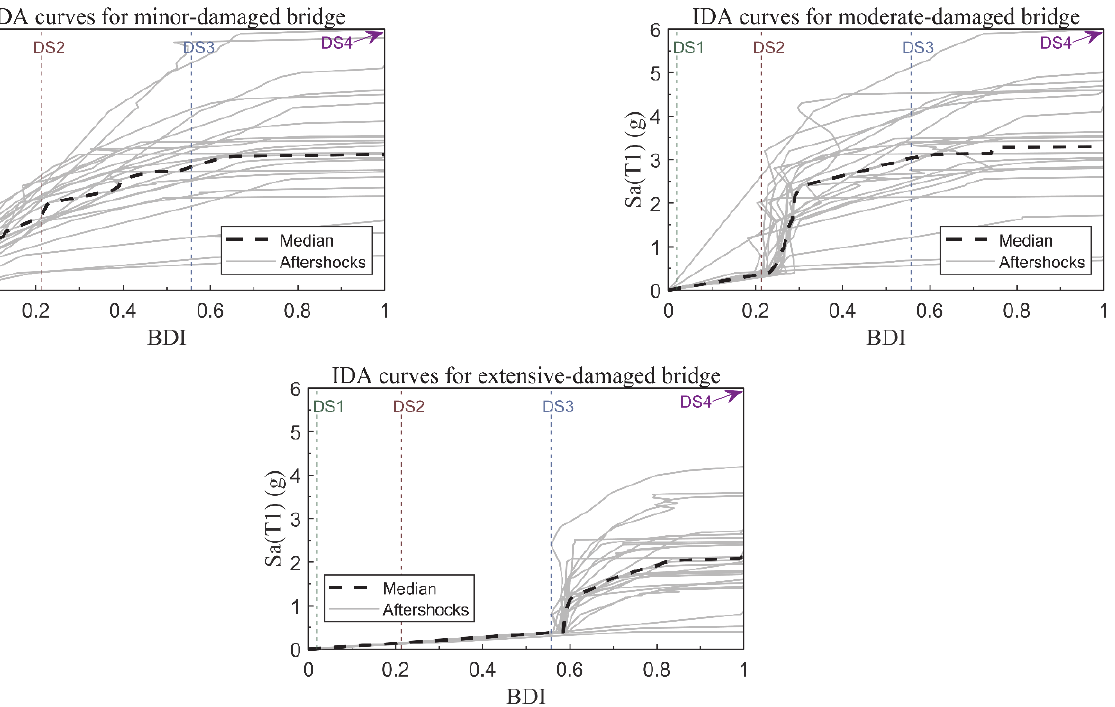
Figure 11. IDA curves of aftershocks for the bridge in minor, moderate, and extensive damage states.